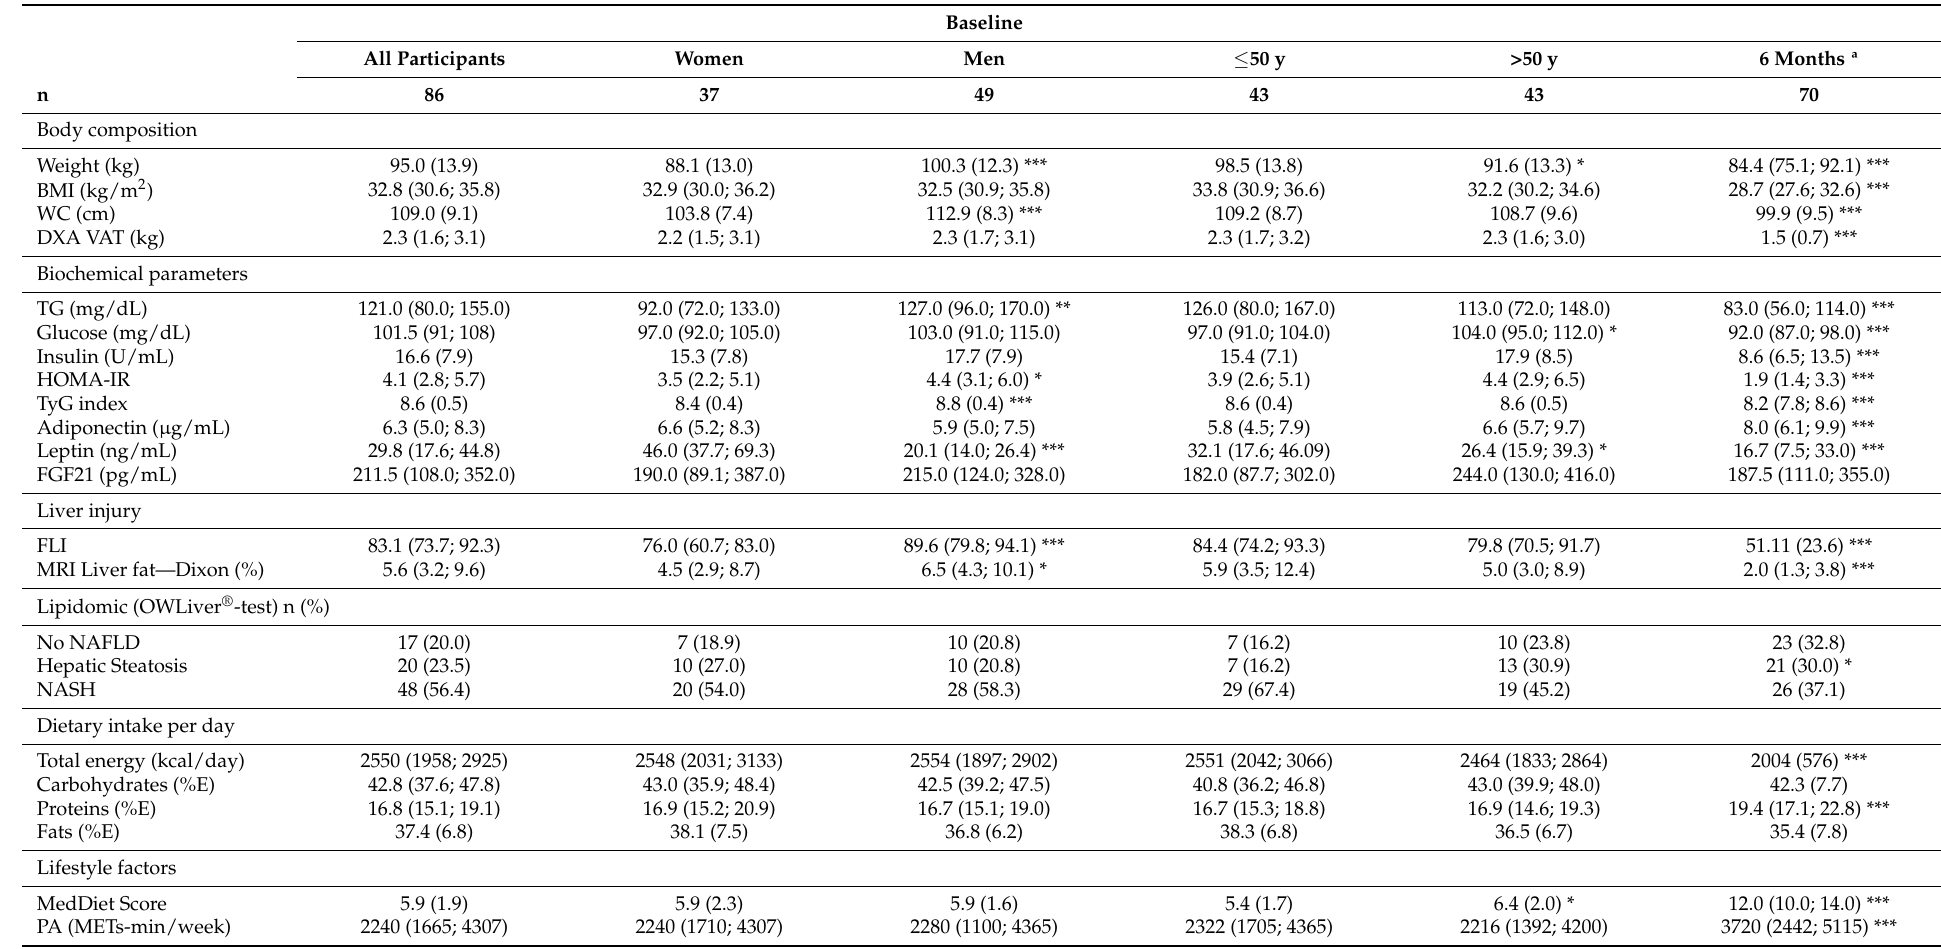
Table 1. Baseline characteristics and after 6 months of dietary intervention and according to sex and age.